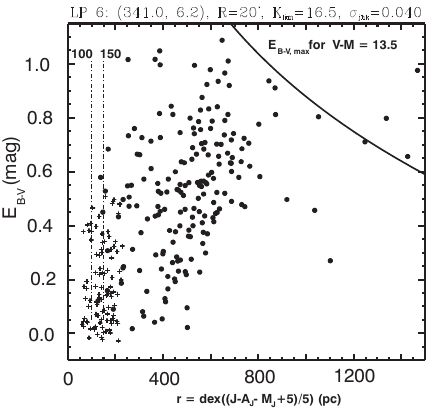
Fig. 2. Color excess E B − V vs. distance in the Lupus 6 direction derived by the main-sequence stars. Dots are for the stars from A0 to G5, and crosses for M-type